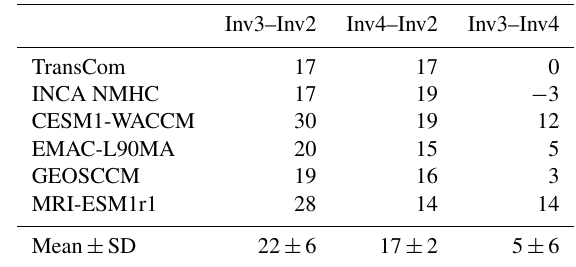
Table 5. Global total emission changes (Tgyr − 1 ) from the early 2000s (July 2000–June 2002) to the late 2000s (July 2007– June 2009) calculated to identify the effect of OH fields (Inv3– Inv2), the effect of OH fixed to the early 2000s (Inv4–Inv2), and the contribution of OH changes from the early to late 2000s to top- down estimated CH 4 emissions changes